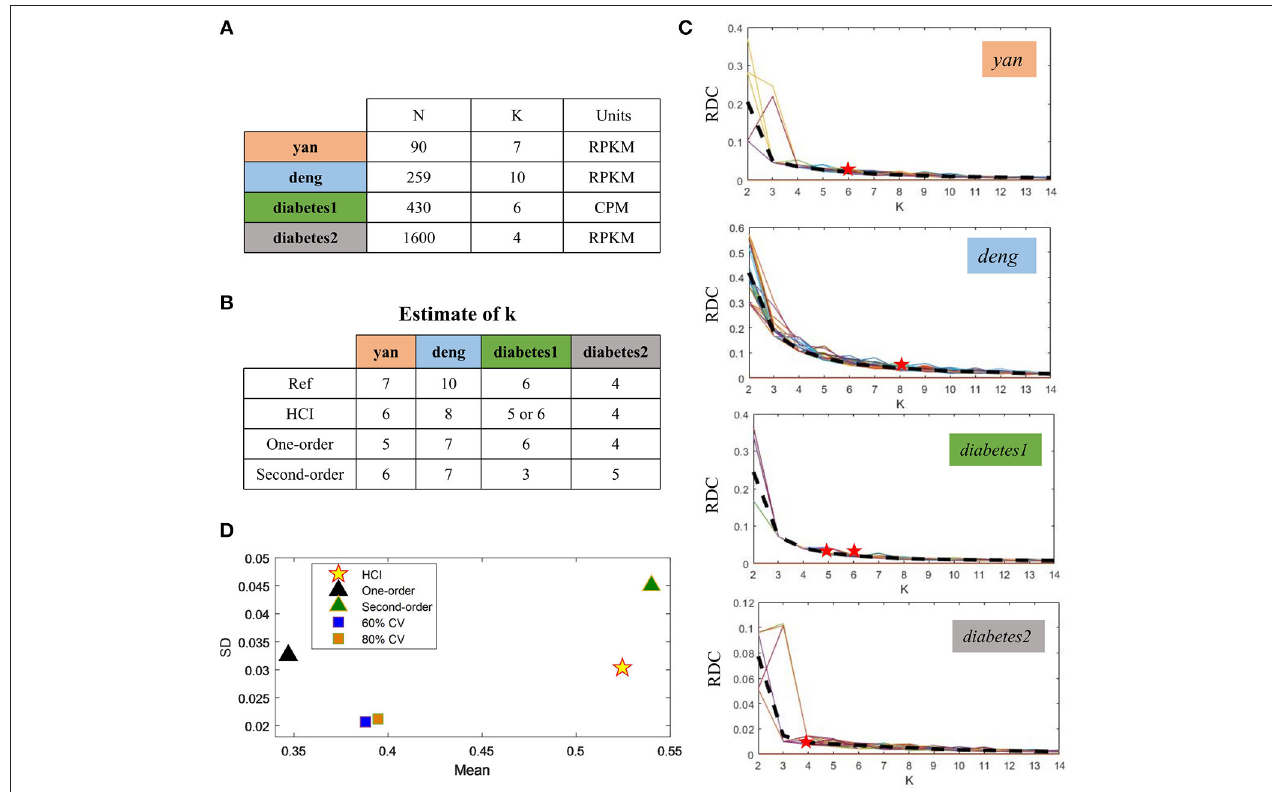
FIGURE 2 | Accuracy and robustness evaluation (A) A brief introduction of four published datasets used in HCI. N is the number of cells in a dataset; K is the number of clusters originally identified; Units: FPKM is Fragments Per Kilobase of transcript per Million mapped reads, CPM is Counts of per Million mapped reads. (B) Number of clusters K predicted by HCI, One-order situation, Second-order situation, 80% CV used and 60% CV used for all datasets. Ref is the cell cluster reported in previous studies and used as reference of comparison among HCI, One-order situation, and Second-order situation. (C) RDC was applied 100 times in global sample-pattern matrix Y to each dataset. The solid lines correspond to the value of each RDC calculation. The dashed black lines correspond to the average of these solid lines. Y-coordinate in each graph represents the RDC value and the x-coordinate represents the number of cluster K . The star indicates K which we choose (see methods). (D) The mean and standard deviation of ARI in four datasets by running k-means 50 times separately in different situations.